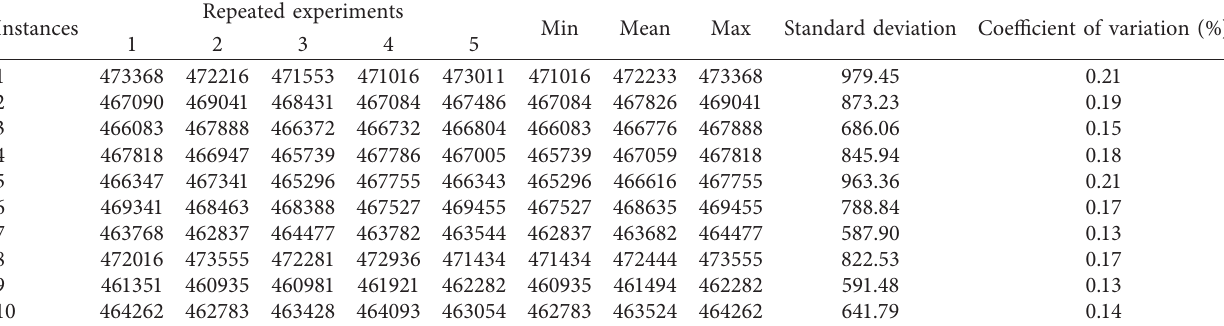
Table 14: Results of repeated